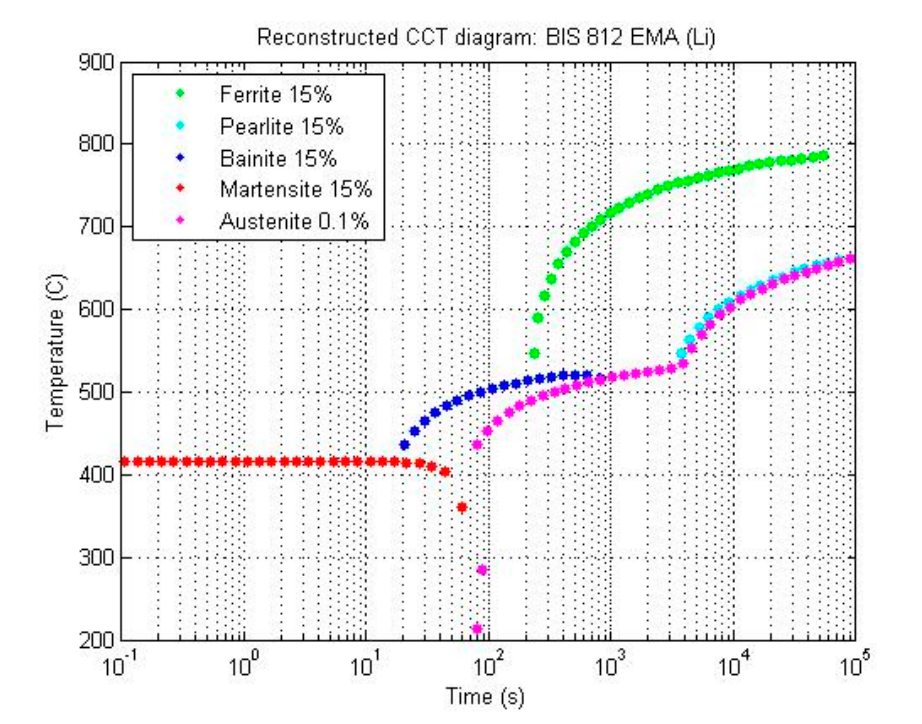
Figure 2. CCT diagram for BIS 812 EMA steel [14].